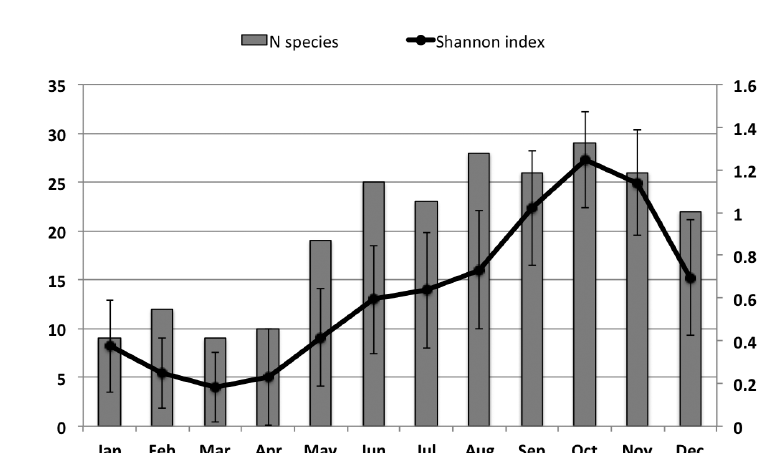
Figure 6. Seasonal patterns of tintinnid species richness (N species, left axis) and diversity index (Shan- non Index + stdev, right axis) in the period from July 1998 to July